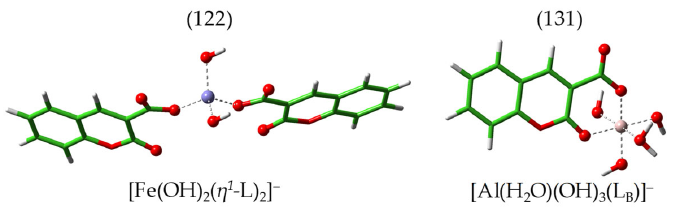
Figure 3. Optimized structures of the tetrahedral 1:2 Fe:HCCA and octahedral 1:1 Al:HCCA com- plexes.